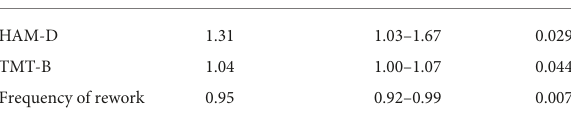
TABLE 5 The binary logistic regression analysis with likelihood ratio method (forward selection) for restoration group in work restoration.